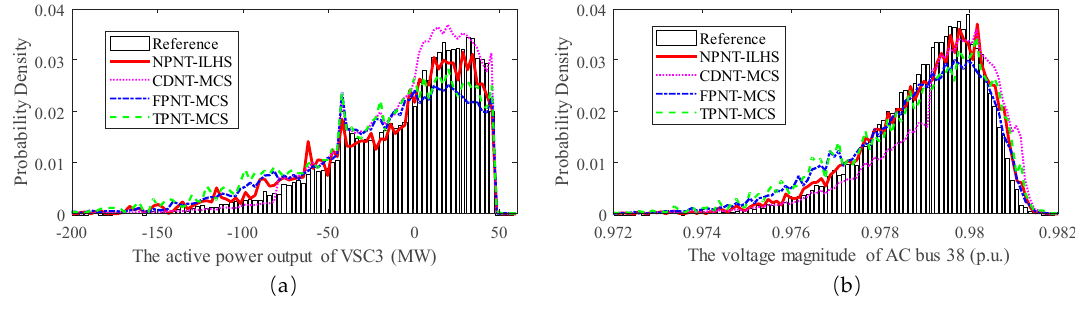
Table 5. FHSIs obtained by using NPNT-ILHS, CDNT-MCS, FPNT-MCS, and FPNT-MCS.